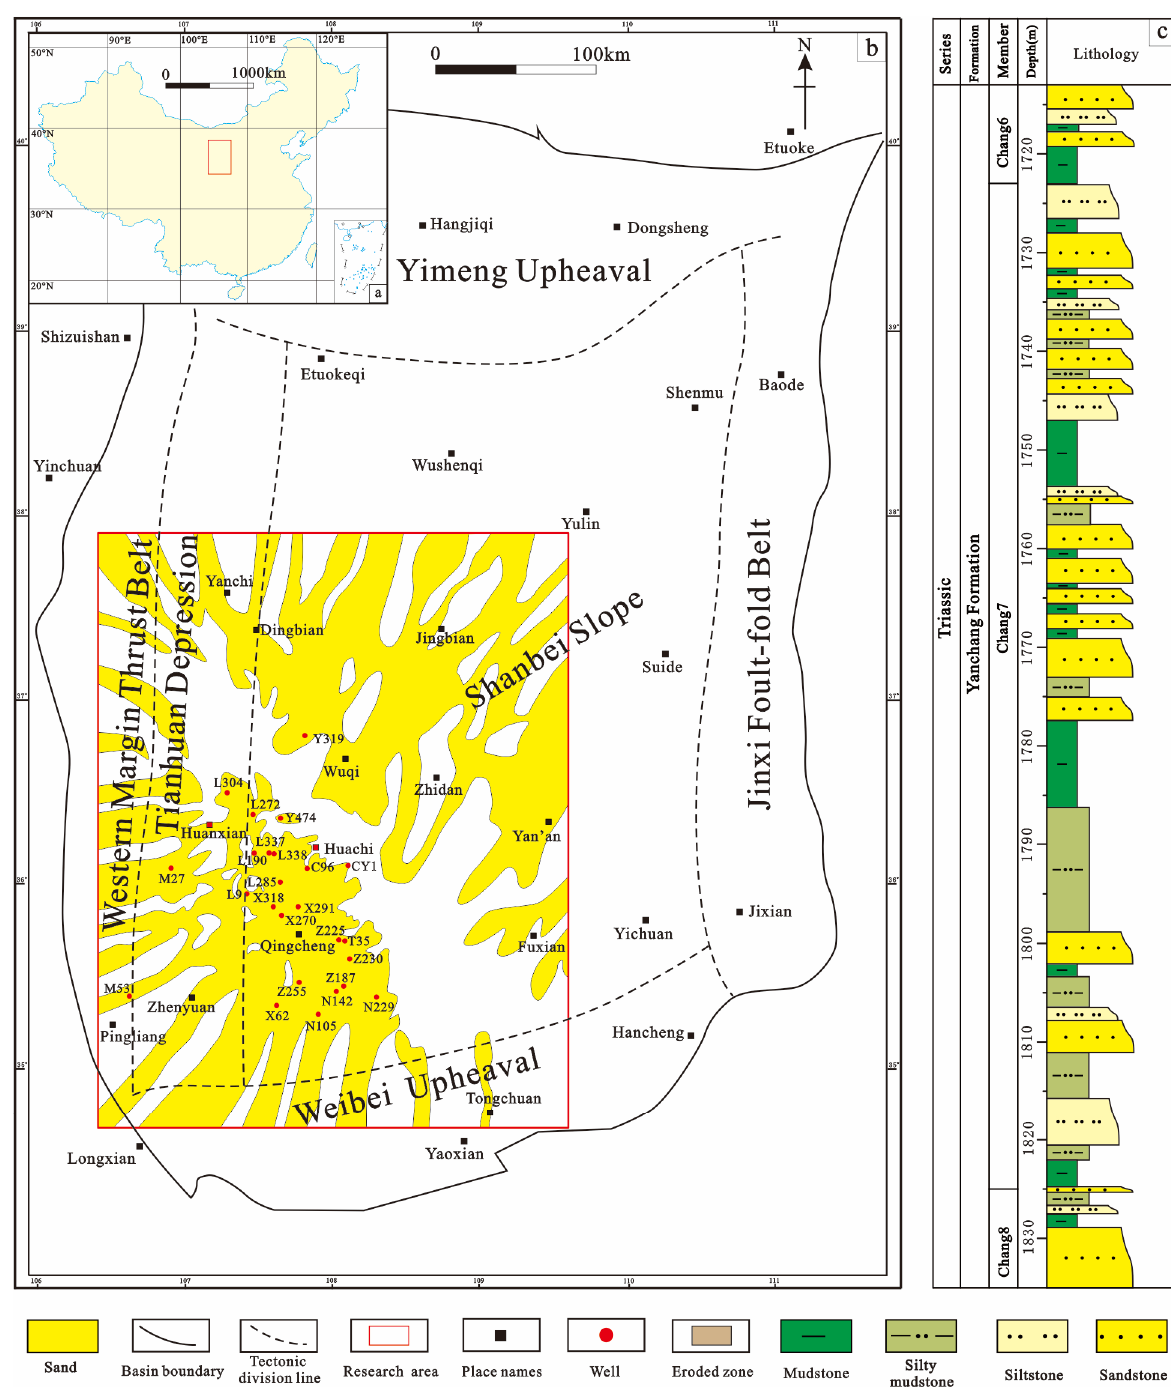
Figure 1. ( a ) Location of the Ordos Basin, China. ( b ) The geological background of the Ordos Basin, the study area, and the sampling well location; ( c ) lithologic profile of the Chang-7 Member strata [28–32].